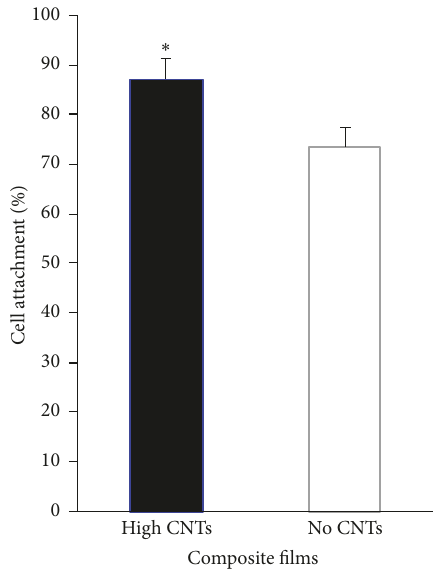
Figure 6: Adhesion of mesenchymal stem cells on silicone-collagen substrates with high CNTs and no CNTs. ∗ 𝑝 < 0.05 for high CNTs versus no